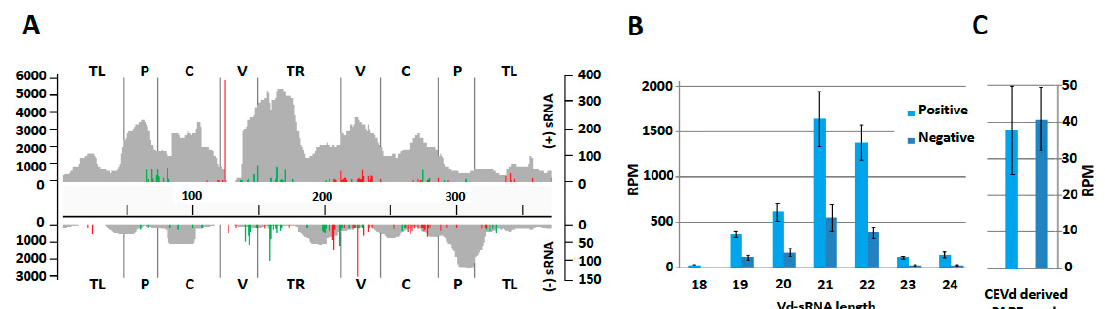
Figure 2. ( A ) Distribution of vd-sRNAs along the CEVd genome (positive strand above and negative strand below) and in the five domains. (18–24 nt). Most frequent 5 ′ and 3 ′ ends of RNA ends are depicted in green and red respectively. The left scale refers to vd-sRNA position count, while the right scale refers to the number of 5 ′ and 3 ′ RNA ends. The five pospiviroid domains are mentioned according to the following abbreviations: TL—Terminal left; P—Pathogenicity, C—Conserved central region; V—Variable; TR—Terminal right. ( B ) Distribution of vd-sRNA according to their length and polarity. Means of read per million (RPM) are depicted with error bars showing the standard deviations observed between biological replicates. ( C ) Mean abundances (in RPM) of CEVd derived PARE reads for both polarities.